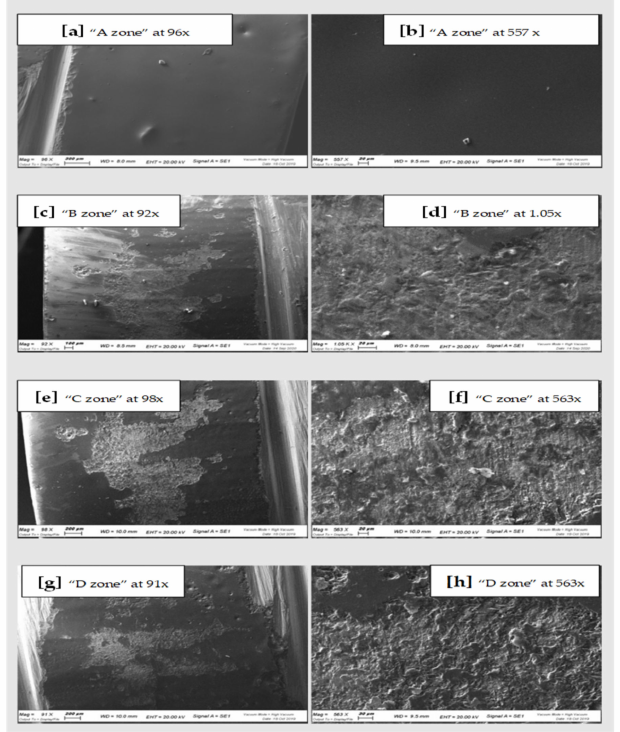
Figure 3. SEM scans of CAD-CAM Zirconia “A zone” ( a , b ), “B zone” ( c , d ); “C zone” ( e , f ) and “D zone” ( g , h ).